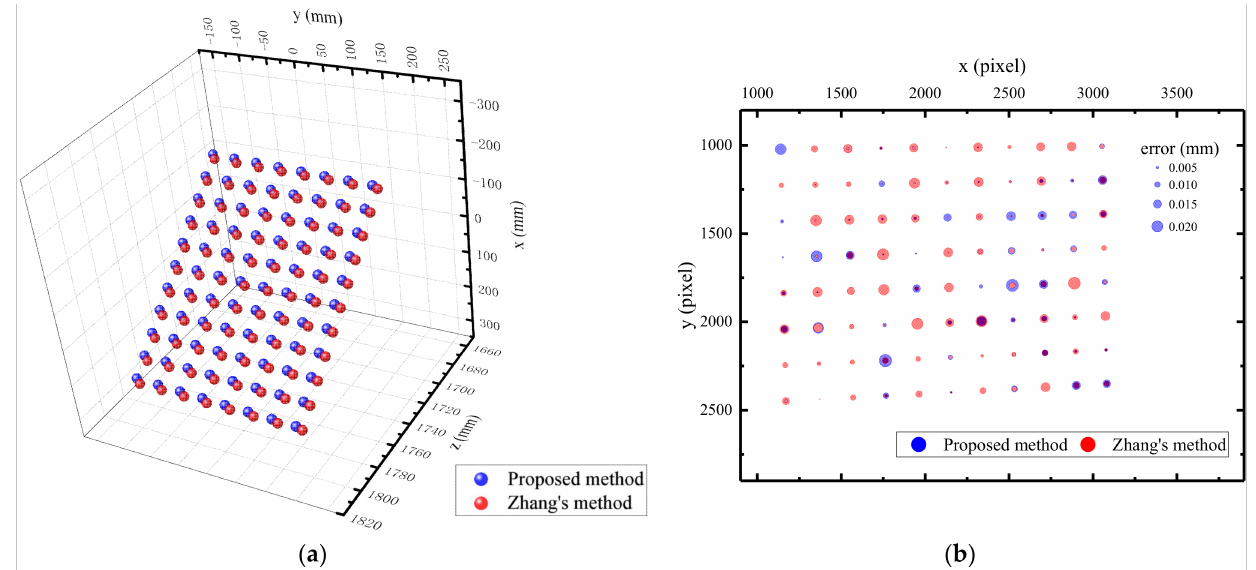
Figure 12. Reconstruction of the checkerboard: ( a ) reconstruction of the chessboard grid; ( b ) error distribution of the chessboard